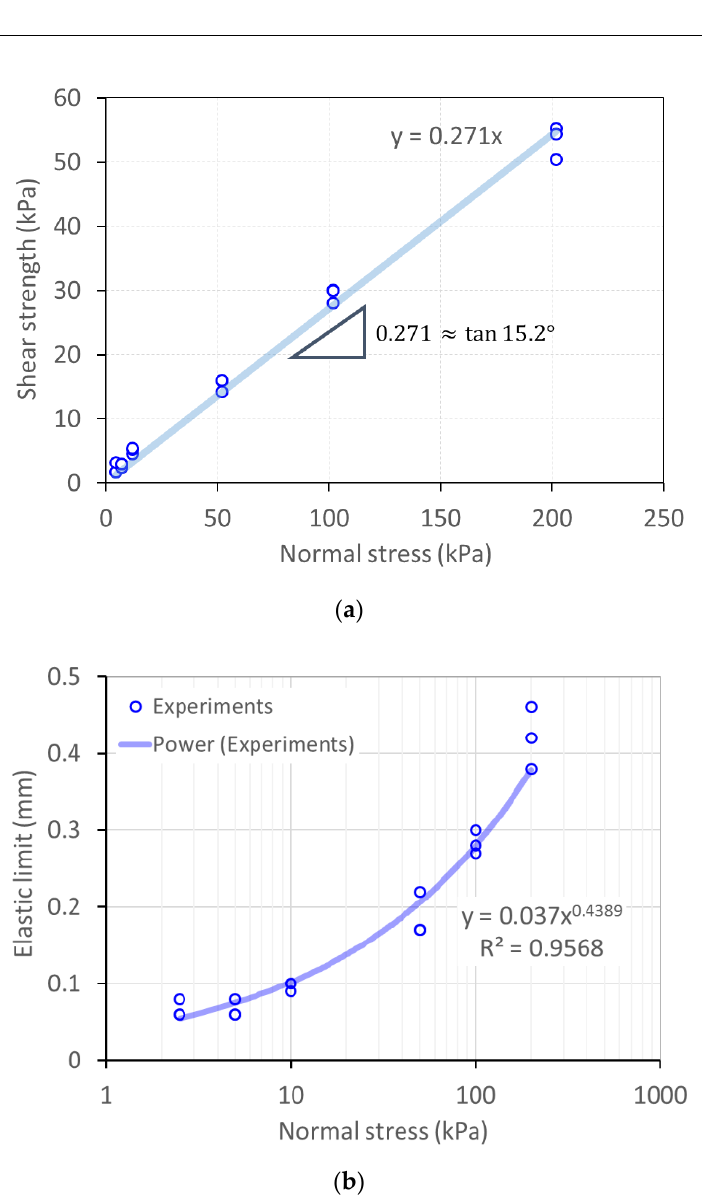
Figure 4. Results of the direct shear test at the acryl-wood interface; ( a ) determination of the frictional coefficient ( 𝜇 ), and ( b ) elastic limits of the shear displacement ( 𝛿 ) under various normal stresses and their regression fitting.